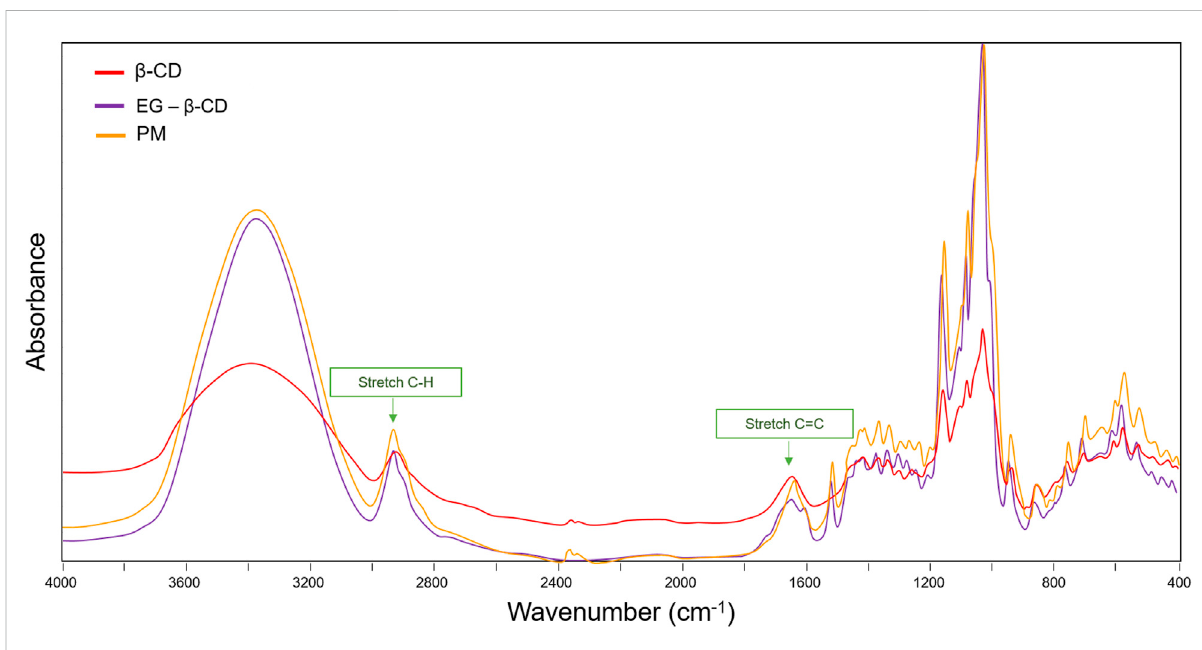
FIGURE 4 Comparative spectra between free β -cyclodextrin, inclusion complex, and physical mixture.